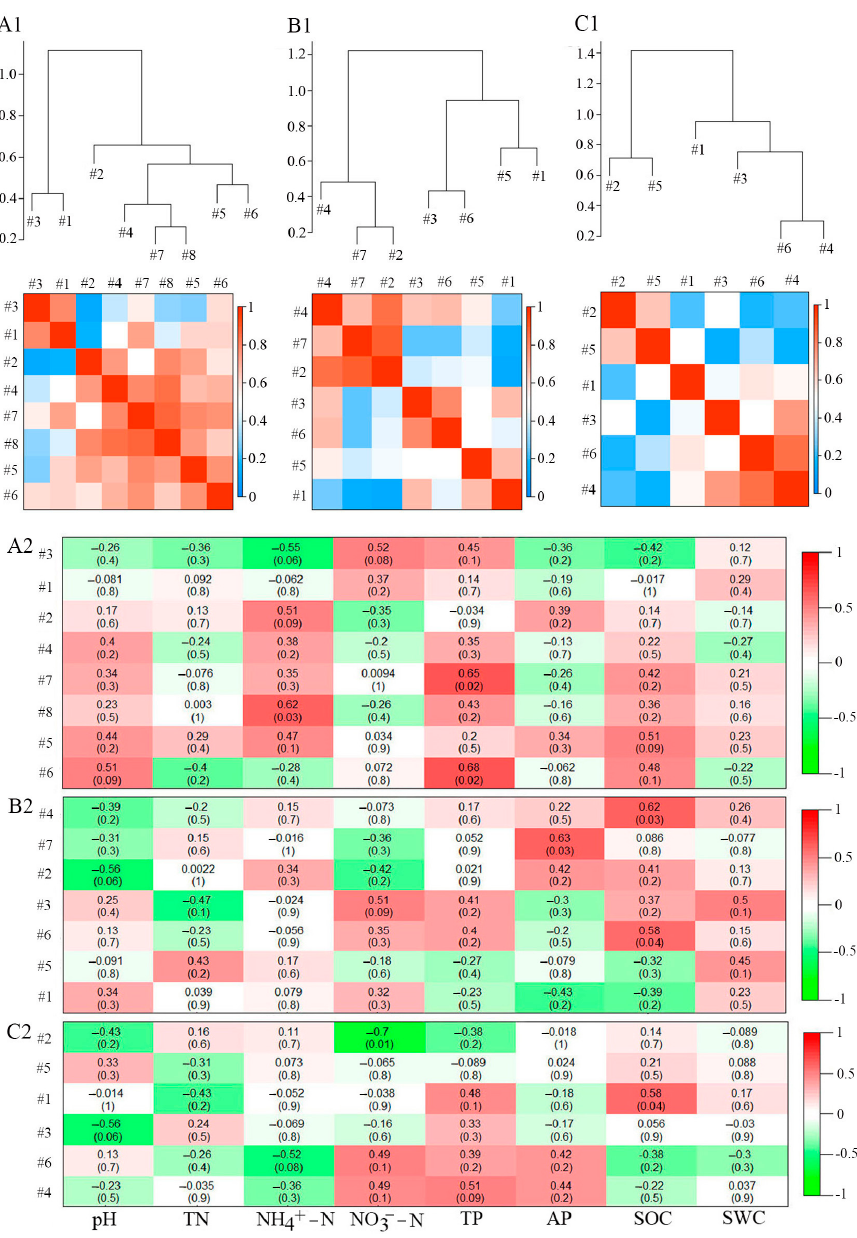
Figure 5. Hierarchical structure of three soil bacterial molecular ecological network modules and its correlation with soil physical and chemical properties. ( A1 , B1 , C1 ) represent the hierarchical structure diagram and heat diagram of representative modules of soil bacterial molecular ecological network in the topsoil, middle layer, and subsoil, respectively. Among them, the upper part was the hierarchical clustering structure diagram based on the Pearson correlation between representative modules, and the lower part was the heat map based on the Pearson correlation between representative modules. Red indicates a high correlation, and blue indicates a low correlation. ( A2 , B2 , C2 ) represent the correlation heat map between the representative modules of soil bacterial molecular ecological network and soil physicochemical properties in the topsoil, middle layer, and subsoil, respectively. In those figures, red indicates a high positive correlation, and green indicates a high negative correlation. In each figure, the numbers without brackets and those with brackets represent correlation coefficient (r) and significance ( P ), respectively. # k , Module k , k = 1, 2, 3, . . . . . . . SWC: soil water content;